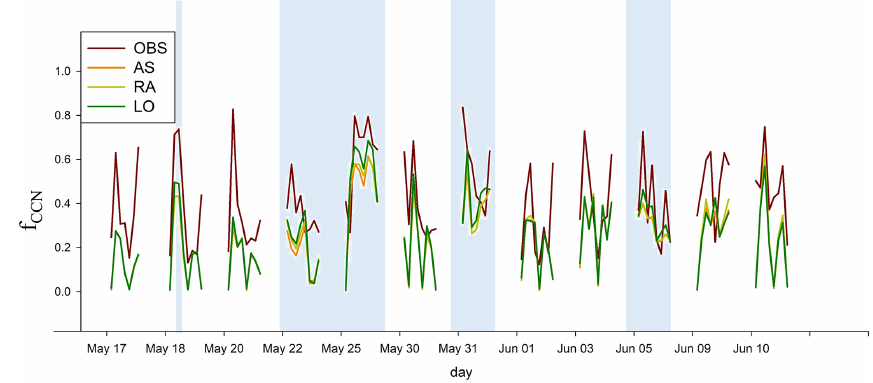
Figure 4. Time variation in the CCN activation fractions at 0.6% supersaturation ( f CCN ) measured by the NASA DC-8 aircraft (OBS) and simulated by AS, RA, and LO. The blue shaded regions denote the time over the